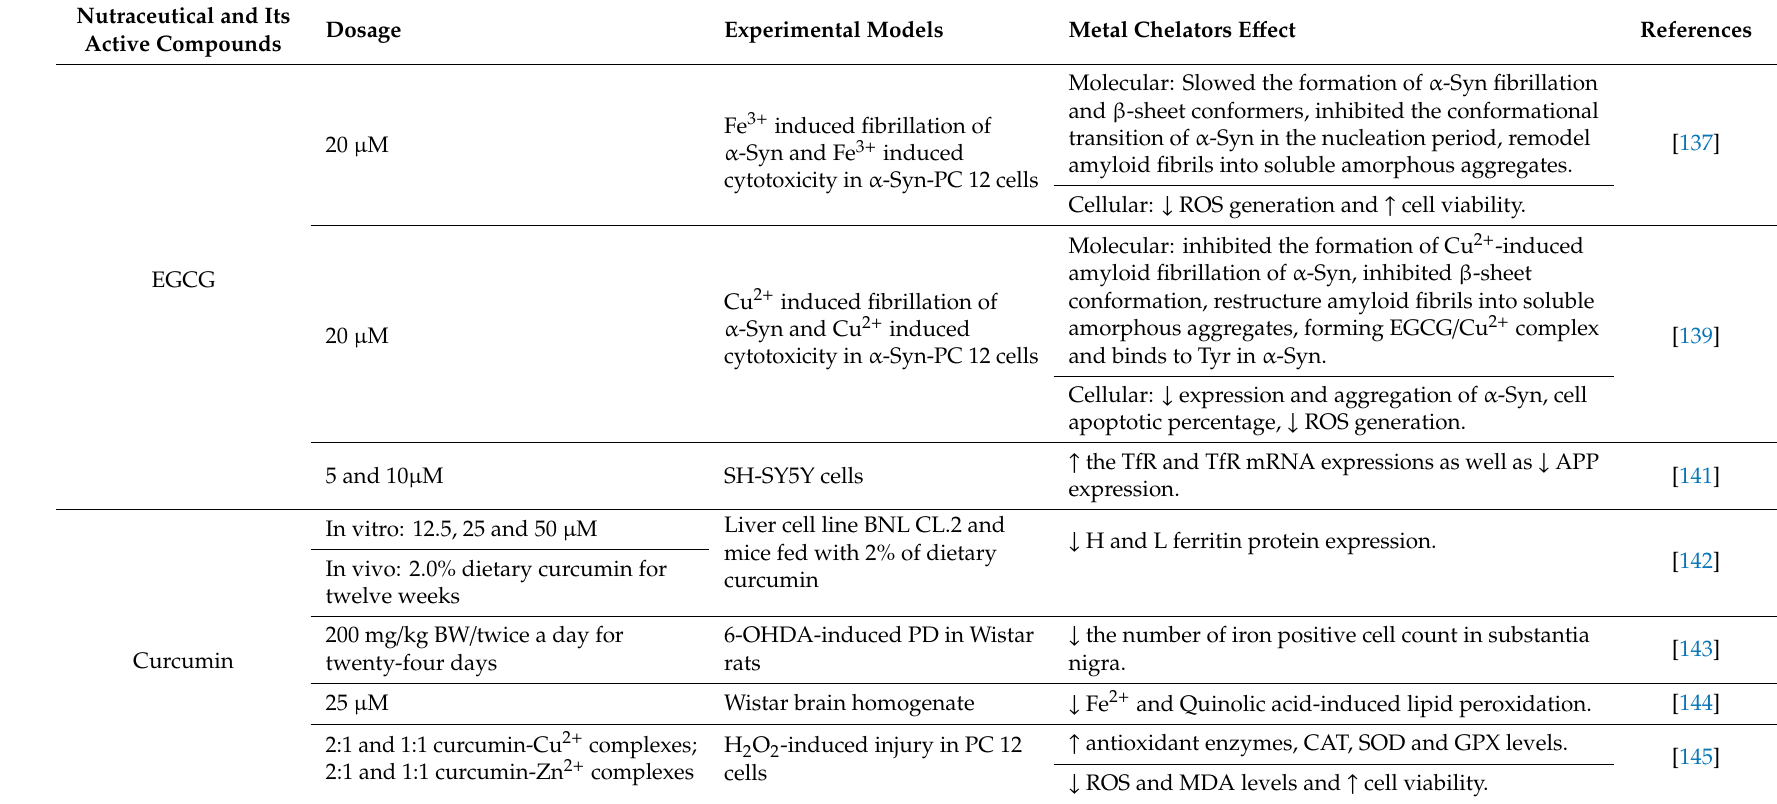
Table 2. Metal chelation activities of